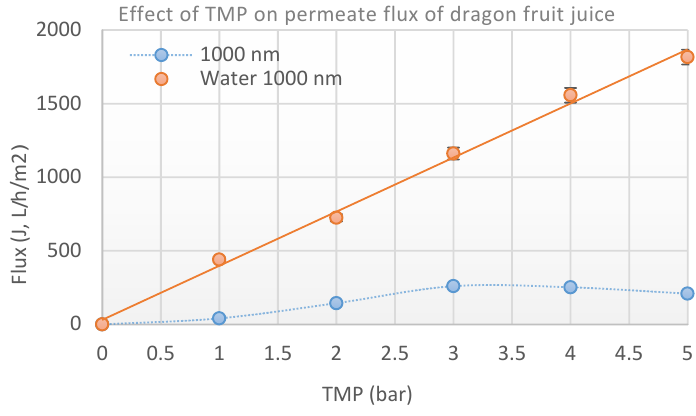
Figure 7. Effect of TMP on permeate flux of dragon fruit juice ( T = 30 °C; membrane = 1000 nm).